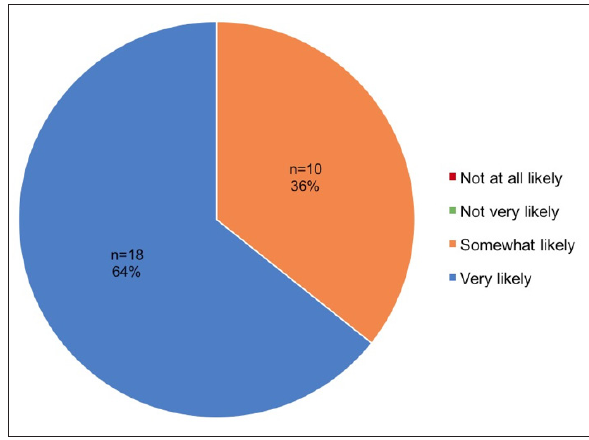
Figure 5: Percent of online questionnaire respondents (N = 28) by response to prompt: “Please describe your like- lihood of participating in the Clark’s Nutcracker Project in the